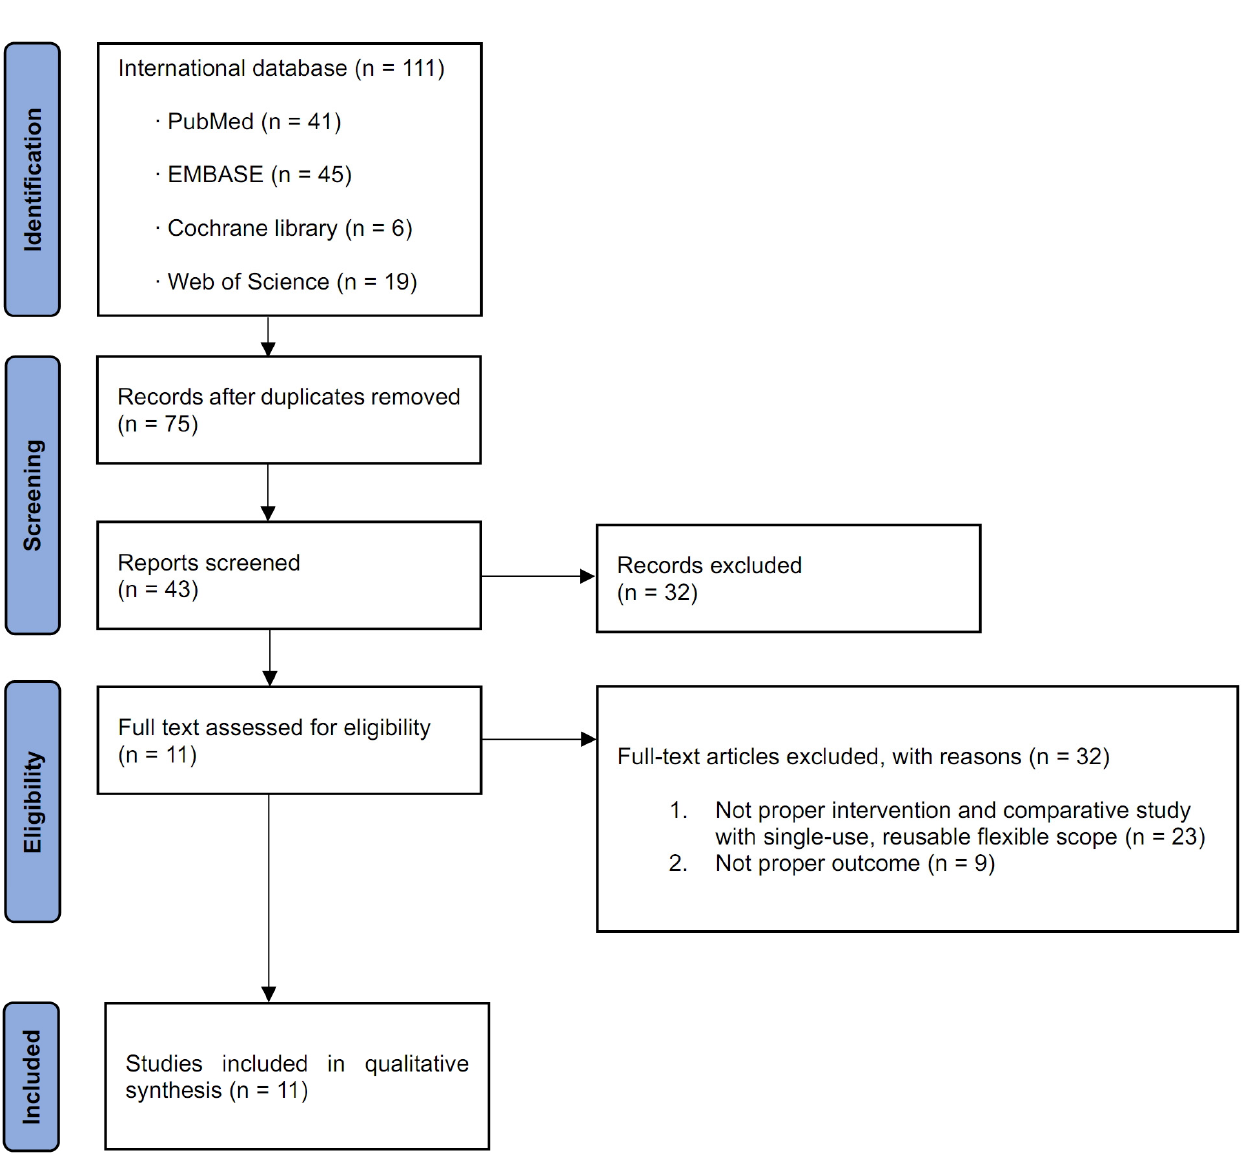
Figure 1. Study selection flow chart.